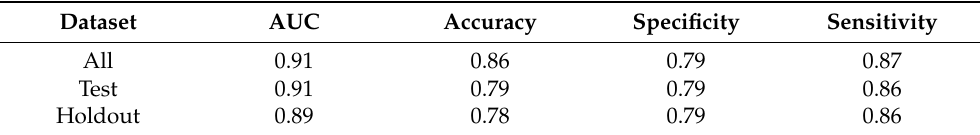
Table 8. Metrics for the best NN